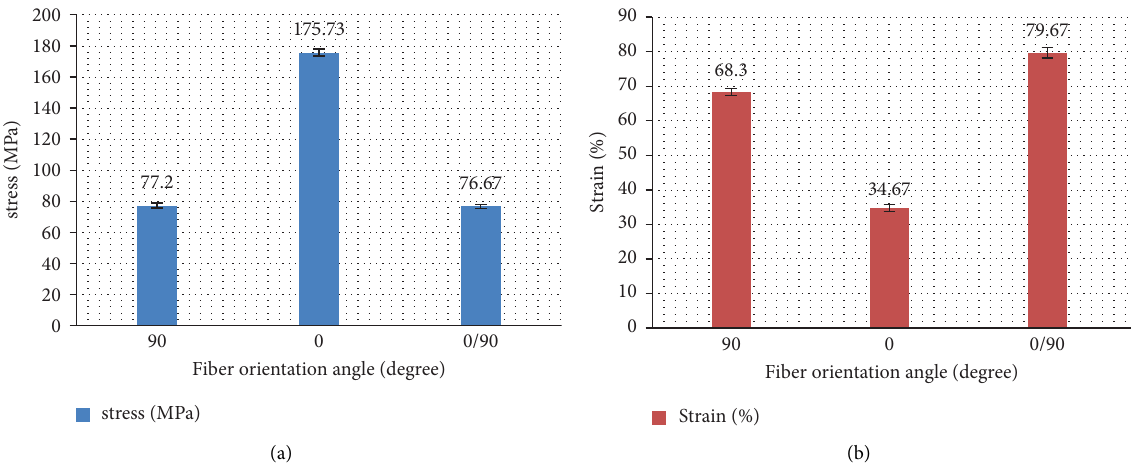
Figure 11: (a) Average tensile strength (MPa). (b) Strain in (%) value of diferent fber orientation graphs.